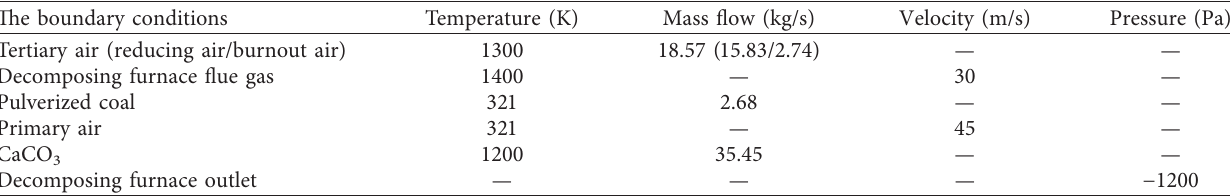
Table 2: Boundary conditions.